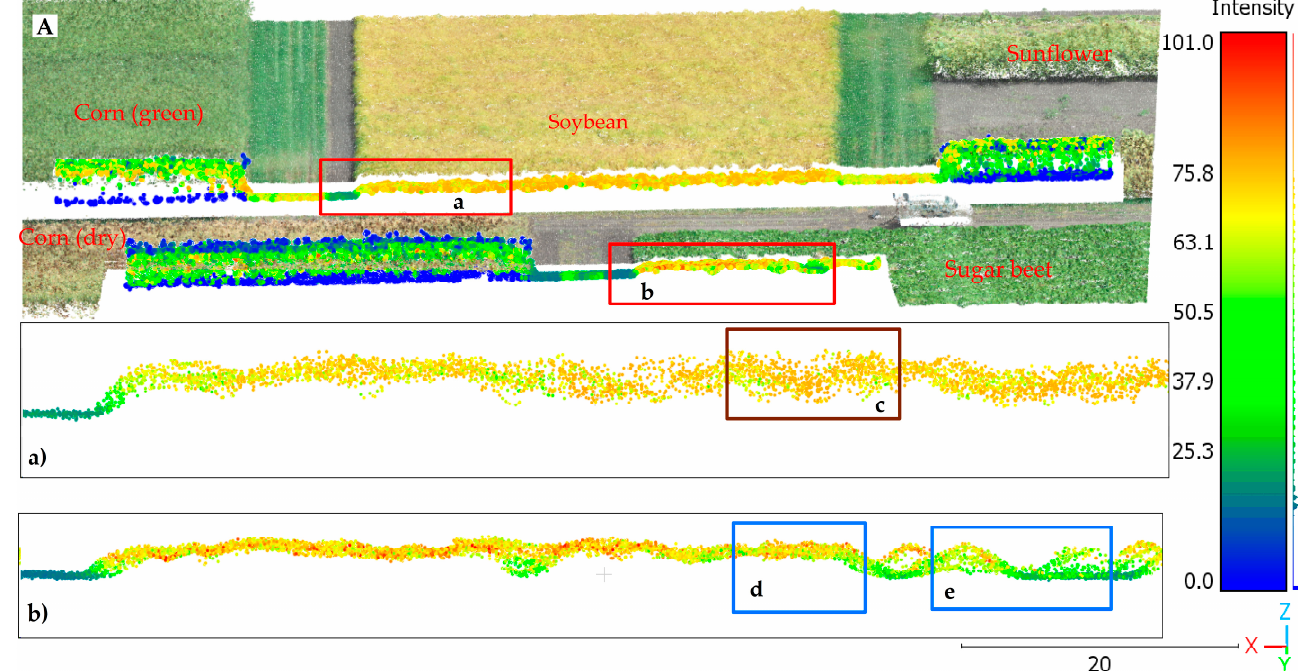
Figure 12. ( A ) Colored DJI L1 point clouds (Site A) with 3D transects of intensity information: ( a ) Transect representative of soybean, and ( b ) sugar beet. ( c ) Complex backscattered UAS ‐ LiDAR point clouds of dry soybean, ( d ) represent sugar beet with only non ‐ ground returns from the top of the canopy, and ( e ) sugar beet with canopy and ground returns. Three ‐ dimensional transects ( a – e ) are of the same extent (horizontal) for visualization purposes with no vertical